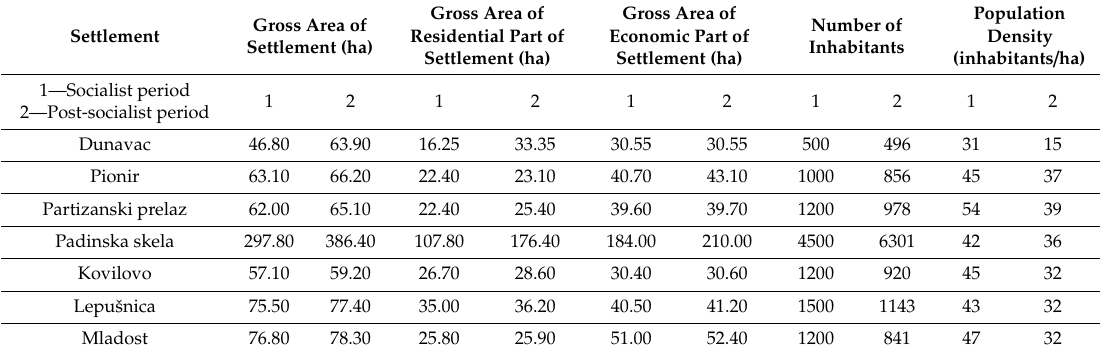
Table 2. Comparative overview of urban parameters for settlements of the PKB Agricultural Combine in the socialist and post-socialist period. Gross Area of Settlement